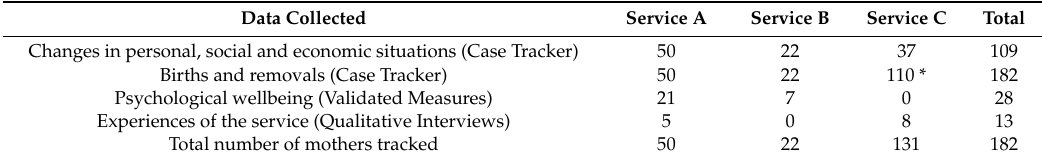
Table 1. Numbers of women tracked in each service